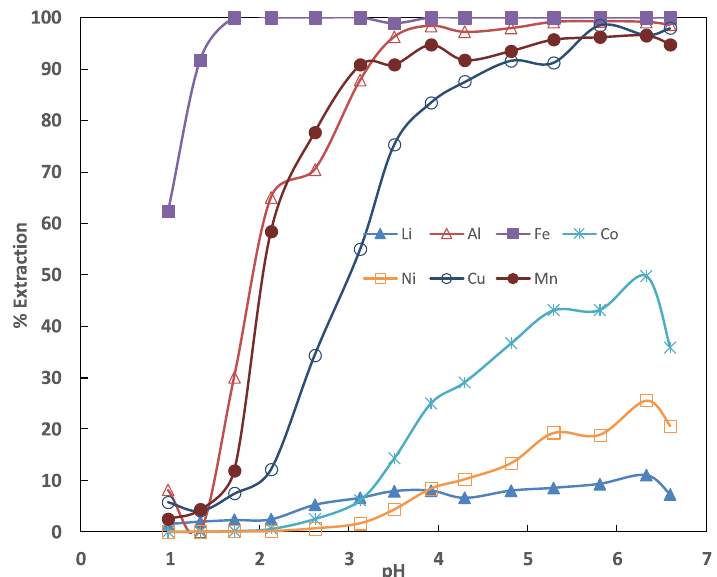
Figure 3. The extraction equilibria of metals using 0.8 M D2EHPA in Exxsol ®